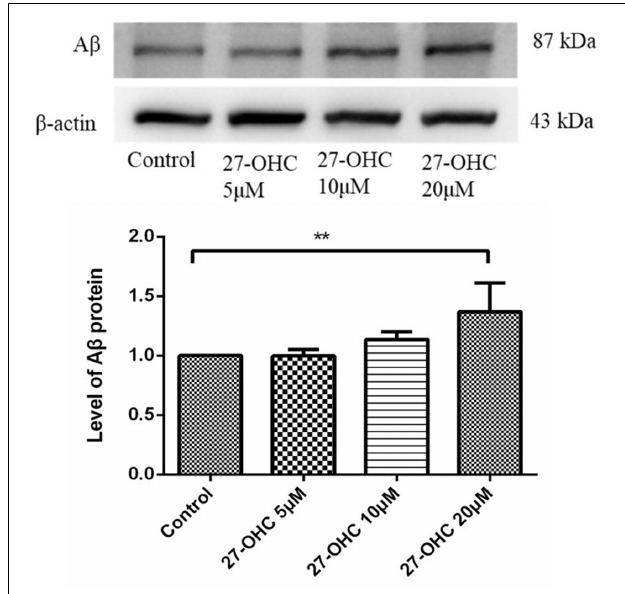
FIGURE 1 | Western blot analysis of A β in SH-SY5Y cells with 0, 5, 10, and 20 µ M 27-OHC for 24 h. Densitometric analysis was normalized with the β -actin blots. ** P < 0.01 compared with the control group (one-way